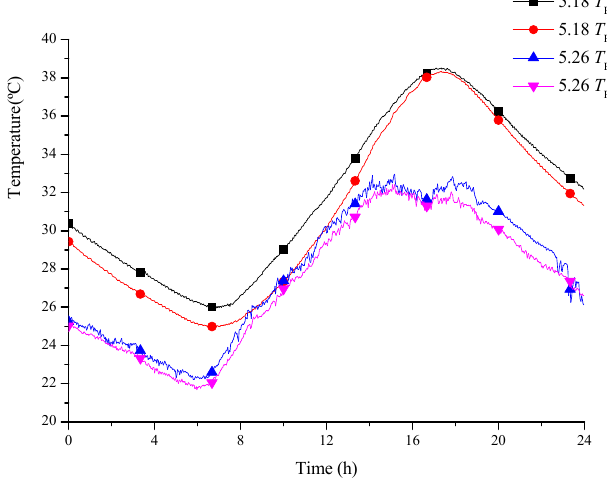
Figure 7. Indoor air temperature comparison between 18 and 26 May (solid wall test system).